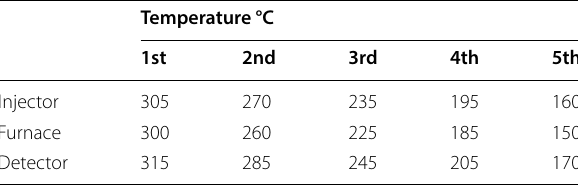
Table 1 Temperature intervals for chromatograph